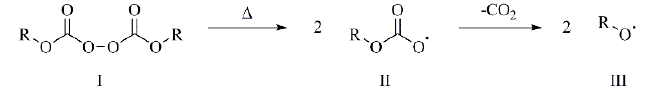
Figure 2. Decomposition of PODIC.